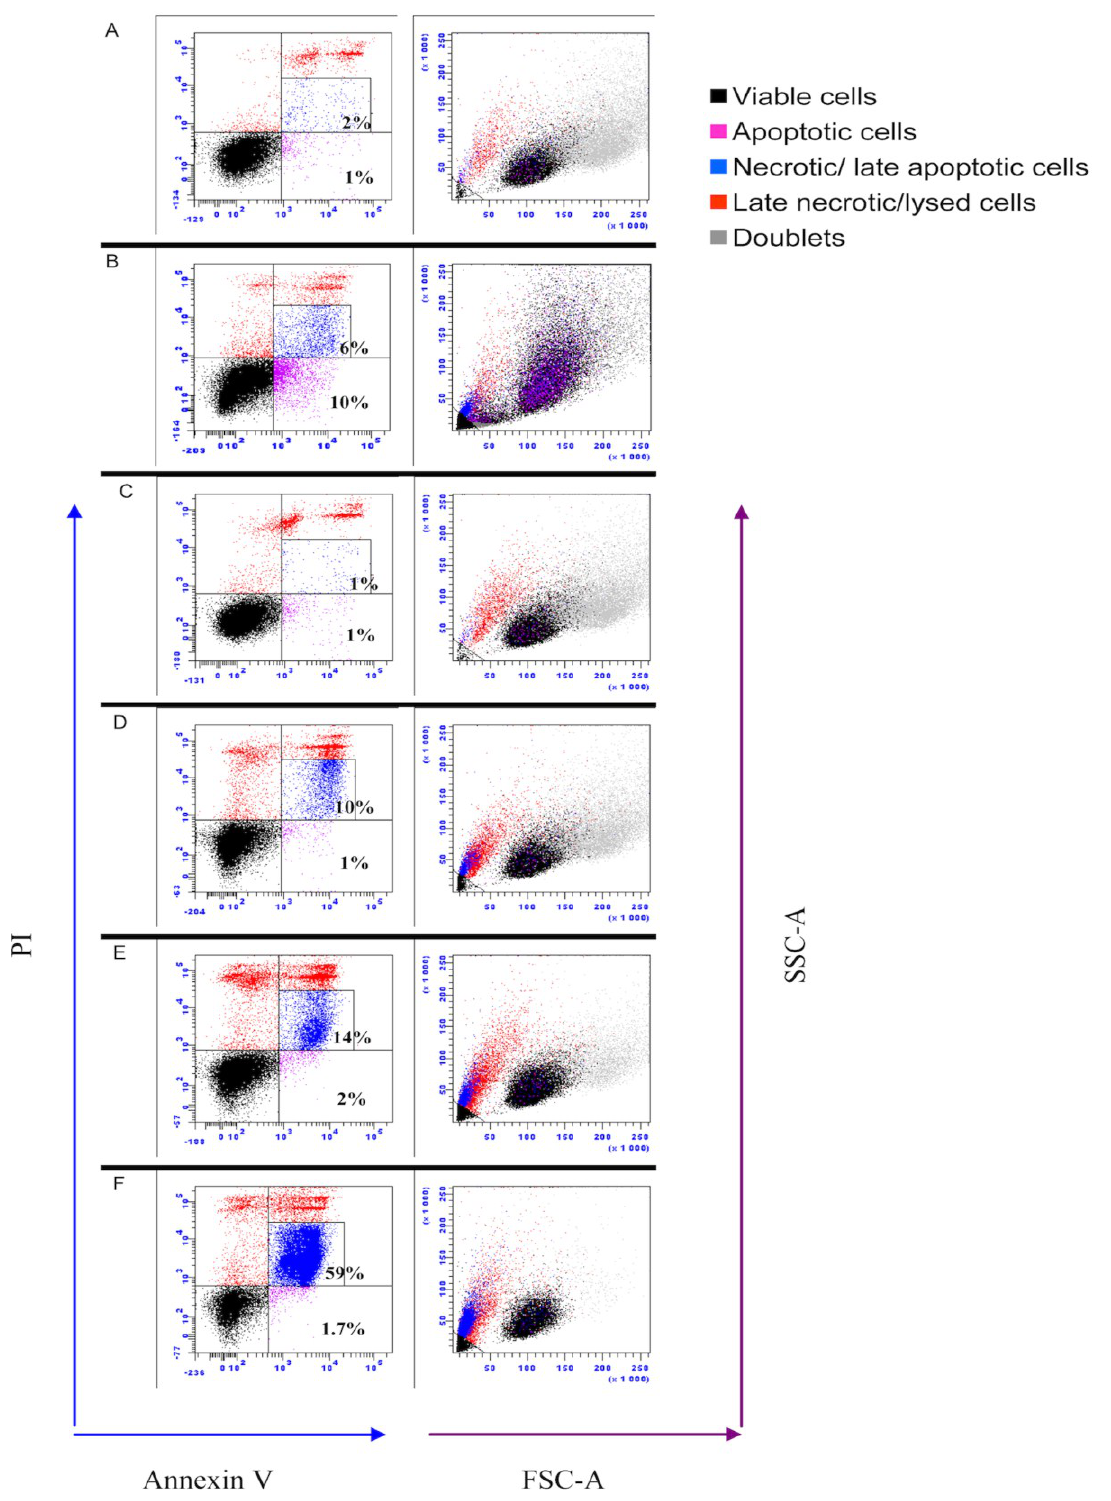
Figure 8. Flow cytometric analysis of infectious pancreatic necrosis virus-infected CHSE-214 cells. Cells were stained with annexin V and propidium iodide (PI) prior to analysis at prescribed time points. A = non infected cells; B = cells treated with staurosporine for 48 h to induce apoptosis; C-F = IPNV-infected cells for 3, 12, 24 and 48 h, respectively. Necrotic cells (blue) have low forward (FSC-A) and side scatter (SSC-A) values. Results provided are representative of at least four independent